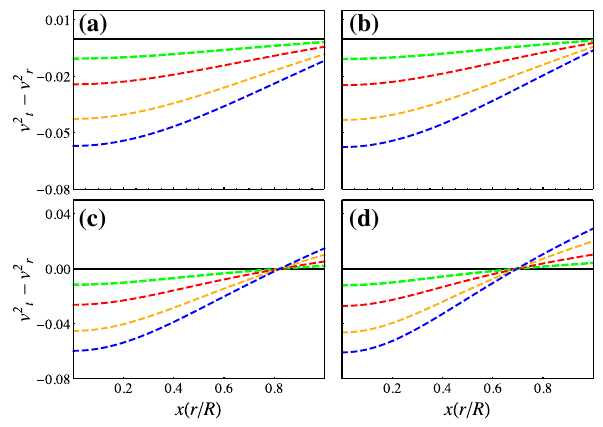
− d ˜ p r Fig. 11 d ˜ p ⊥ for α = − 0 . 1, ˜ ρ a u = 0 . 13, b u = 0 . 15478, d ρ d ρ c u = 0 . 2035, d u = 0 . 229365. α = 0 (black solid line), α = 0 . 04, (green dashed line), α = 0 . 1 (red dashed line), α = 0 . 2 (yellow dashed line), α = 0 . 3 (blue dashed